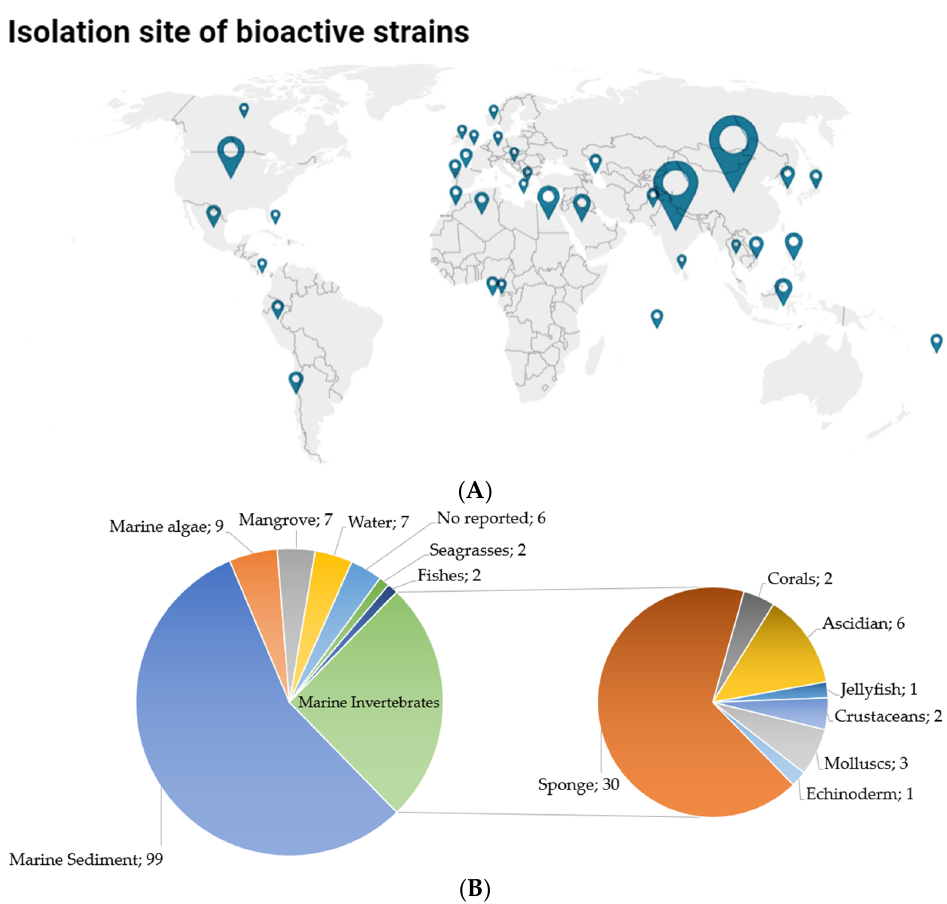
Figure 2. ( A ). World map showing the countries where marine actinobacteria with anti-infective activity were obtained. Max symbol size represents the number of reports. ( B ). Marine actinobacteria with anti-infective activity isolation sources.